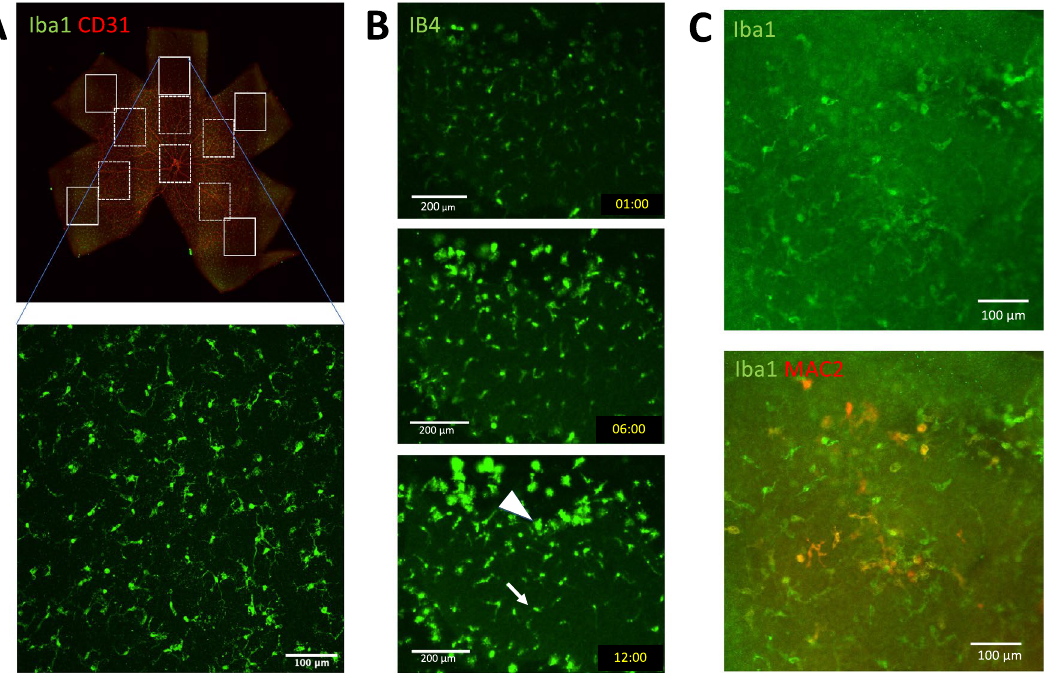
Figure 1. Microglia distribution and morphology. ( A ) Microglia in the peripheral avascular and the central vascular area of a P5 mouse retina. Boxes of the solid line represent the avascular areas, and those of the dashed line represent the vascular areas. ( B ) Observation of microglia in the organ culture. Microglia away from the cut edge remain resting microglia (arrow). Some of the resting microglia were converted to activated microglia (arrowhead) and migrated to the injured peripheral edge during a 12-h time-lapse assay of mouse retina organ culture. ( C ) Activated microglia around the wounded site, stained with MAC2 after the organ